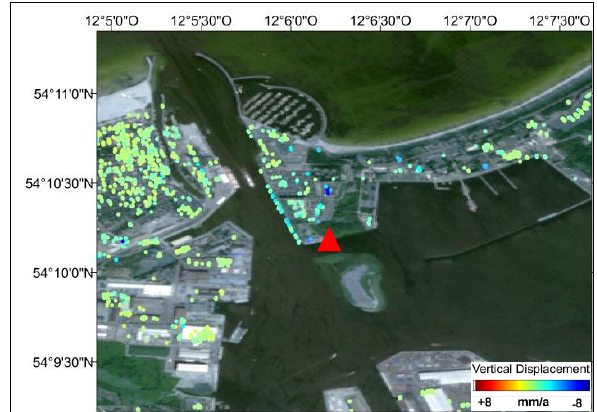
Figure 7: Study area High Dune in Rostock. Red triangle location of gauging station